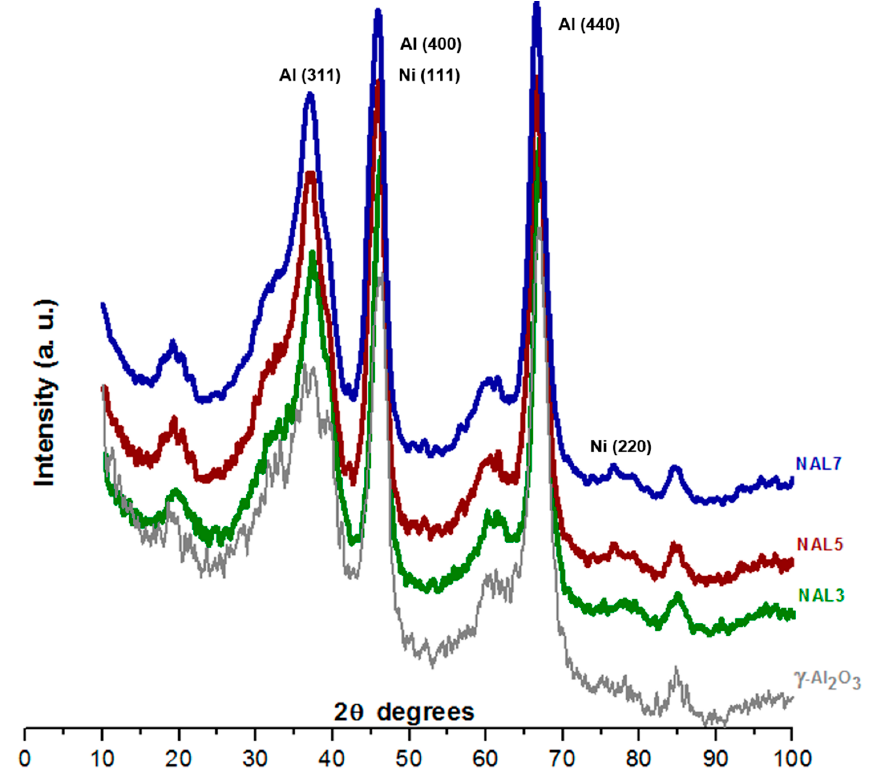
Figure 1. Patterns of X ‐ ray diffraction of Ni/ γ‐ Al 2 O 3 catalysts and γ‐ Al 2 O 3 support.